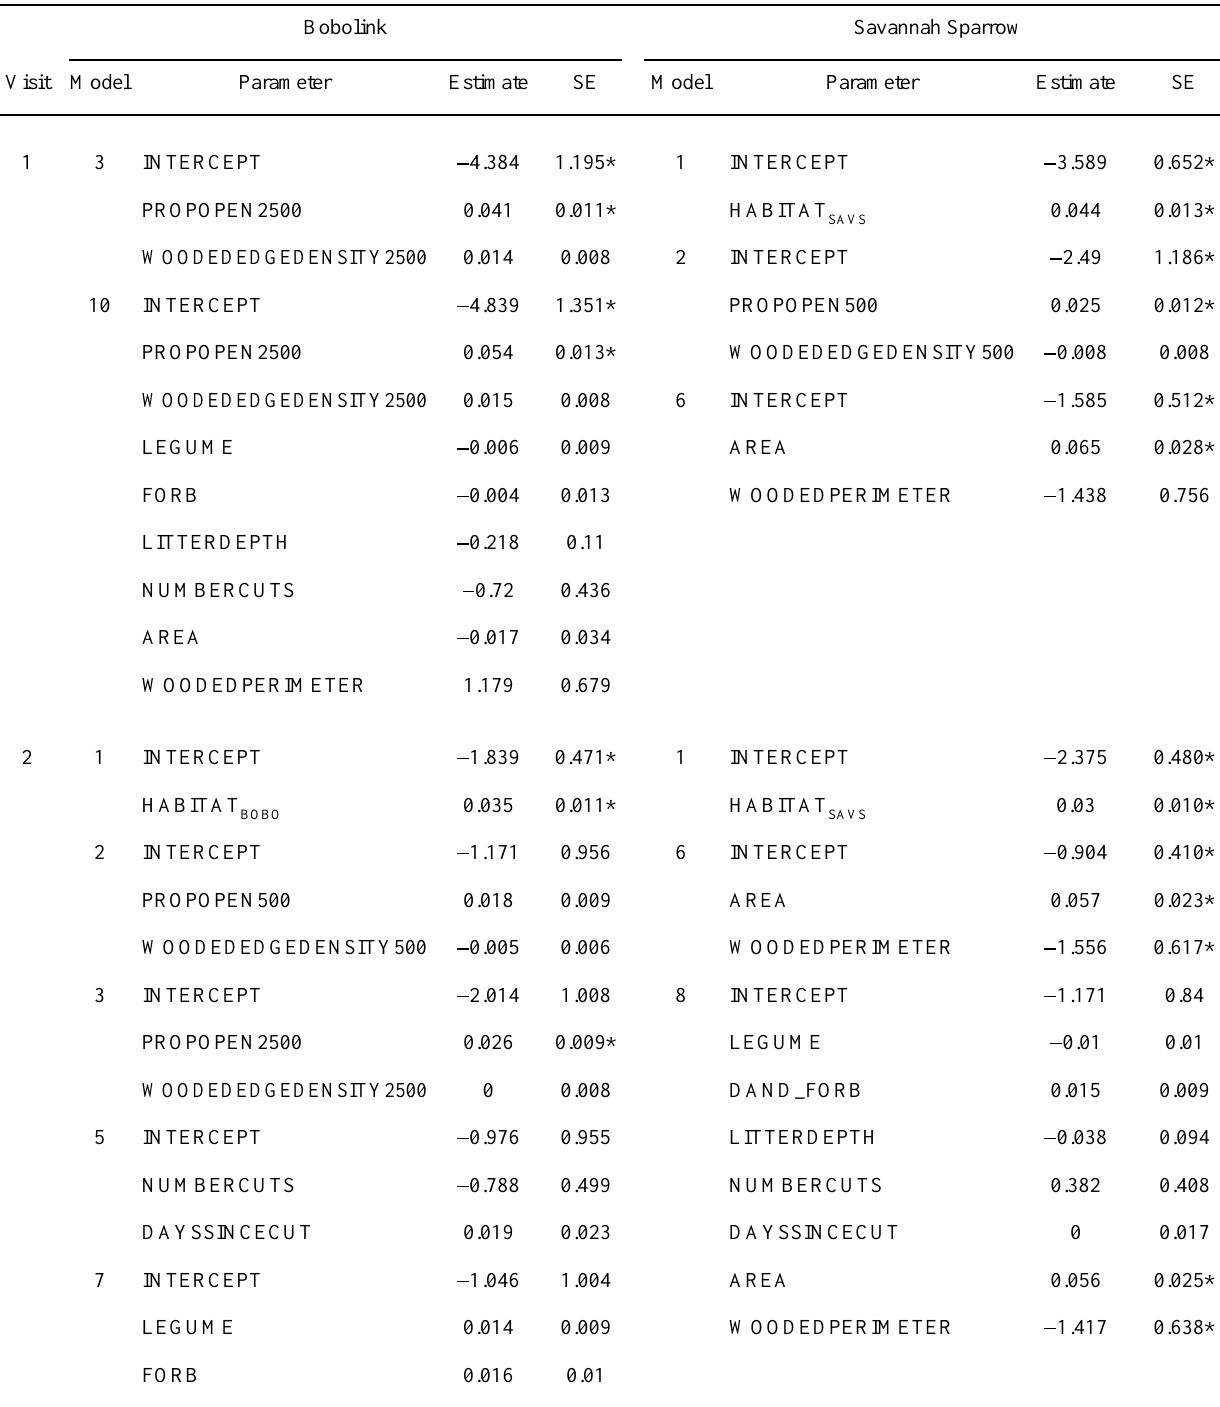
Table 5. Model parameter estimates for supported (contained in 90% confidence set) Poisson regression models reflecting habitat usage hypotheses for male Bobolinks and male Savannah Sparrows based on point count data from May 21 to July 2, 2002 from the Champlain Valley of Vermont and New